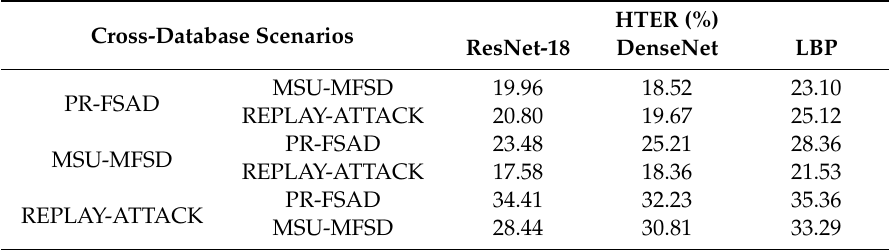
Table 5. Results of cross-database scenarios using ResNet-18, DenseNet, and LBP (1st column: Trained DB, 2nd Column: Test DB).